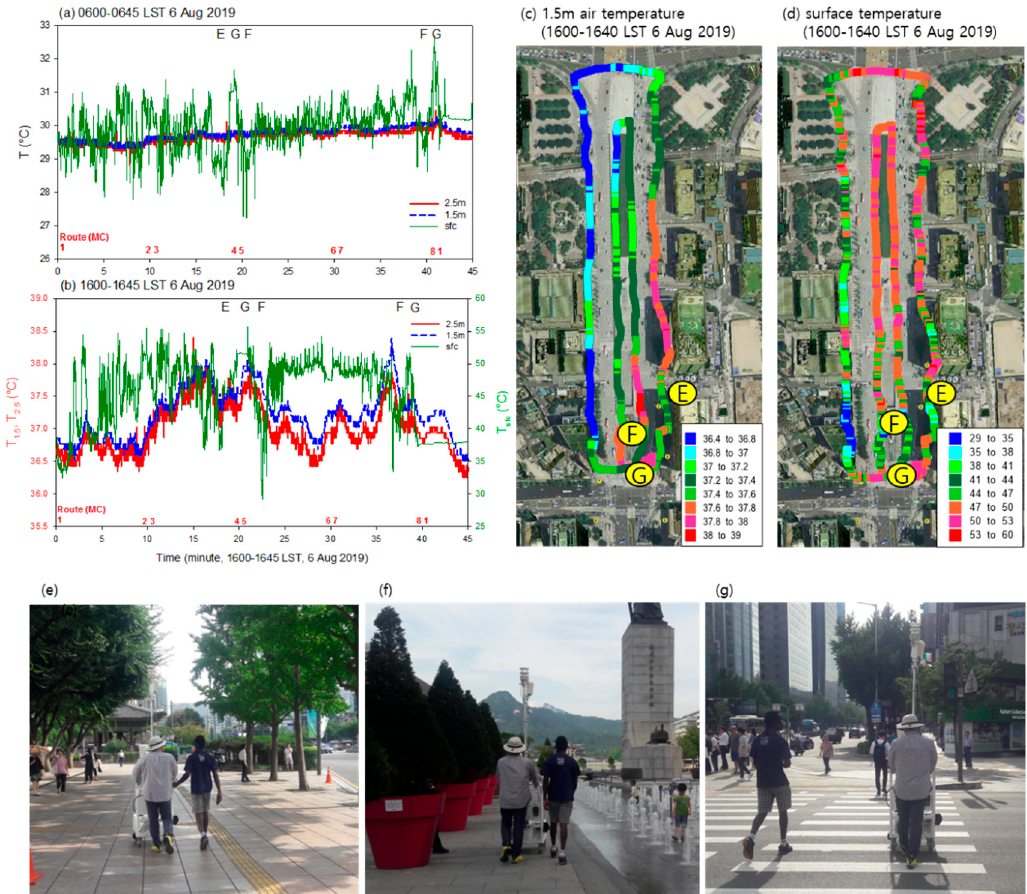
Figure 11. Time series of surface, 1.5 m, and 2.5 m air temperatures obtained by MOCA during ( a ) 0600-0650 LST, and ( b ) 1600–1650 LST on 6 August 2019. Horizontal mapping of ( c ) 1.5 m air temperature and ( d ) surface temperature on satellite image of BBMEX domain. Landscapes at ( e ) point E (tree), ( f ) point F (ground fountain), and ( g ) point G (road) in (a) and (b). Route number in (a) and (b) indicates the location with its heading MC in Figure 3a.